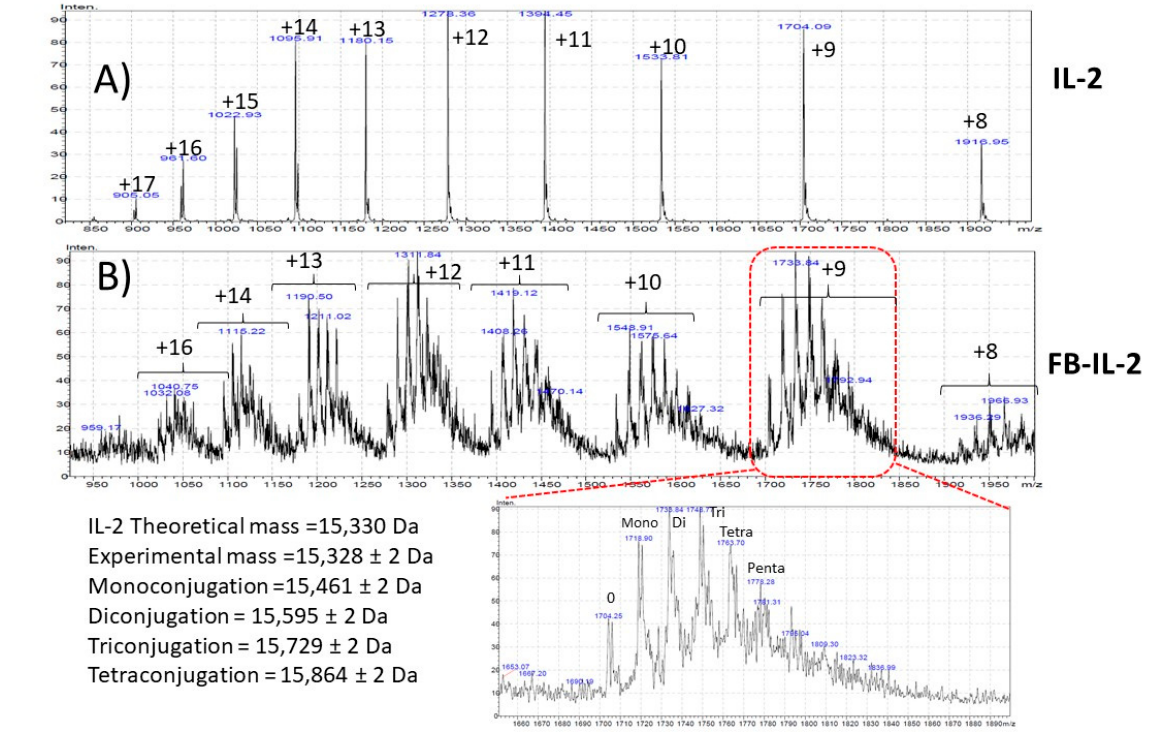
4 of 12 Figure 1. Radio- and UV chromatograms of the PD-10 purified formulated radiotracer, [ 18 F]FB-IL-2. 2.2. Chemical Characterisation of [ 18 F]FB-IL-2 The shelf-life of formulated [ 18 F]FB-IL-2 solution was assessed over 5.5 h at room temperature, during which no change in RCP was observed. Liquid chromatography–